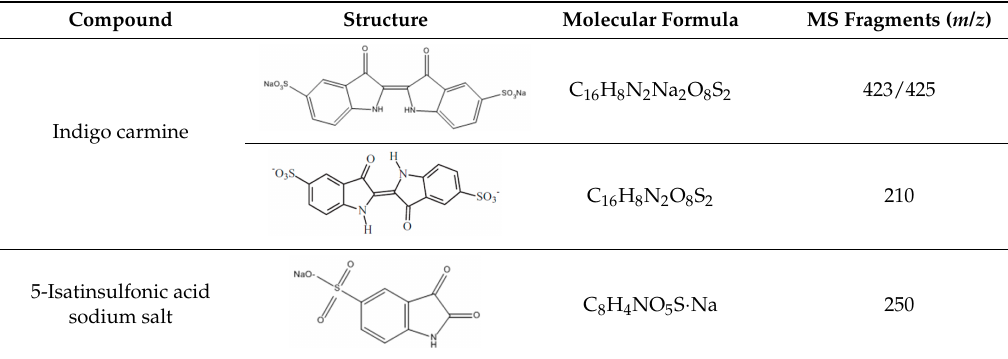
Figure 10. LC-MS analysis of indigo carmine solution adsorbed by plasma regenerated sample. Table 4. Analysis of degradation products by